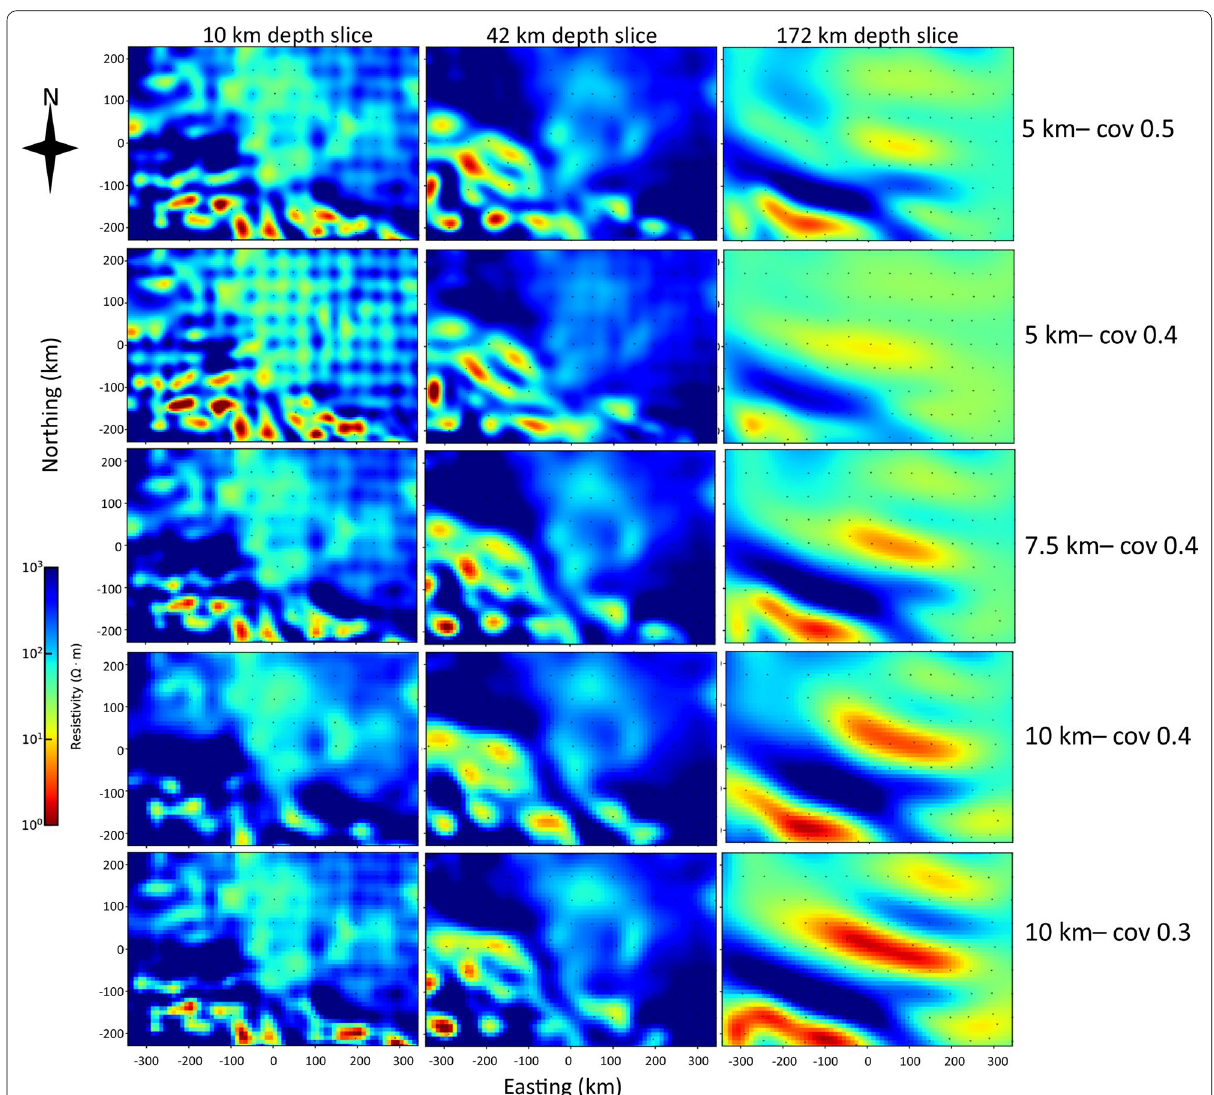
Fig. 15 Modelling of data using different lateral cell sizes of 5, 7.5 and 10 km, respectively. These were run with all the same covariance (0.4) and then with a larger covariance for the 5 km to reduce speckling (0.5) and smaller for the 10 km to get a more detailed model (0.3)